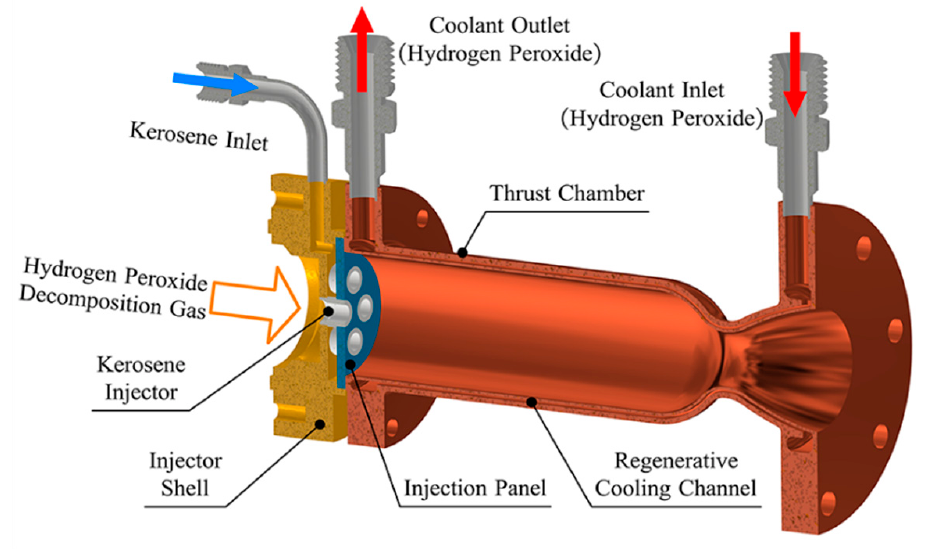
Figure 1. Schematic diagram of engine with regenerative cooling.